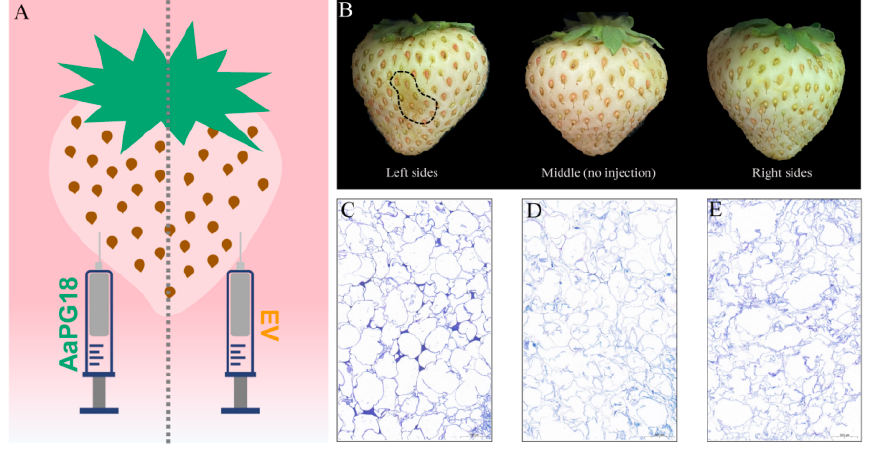
Figure 5. Transient overexpression in fruits of strawberry “snow”. ( A ) Diagrammatic sketch of the transient injection on the left and right sides of the same fruit of strawberry. ( B ) Phenotype observation of strawberry three days after injection. ( C ) Morphological observation of the cell section of strawberry fruit infiltrated with pBI121–AaPG18. ( D ) Morphological observation of the cell section of strawberry fruit without any injection. ( E ) Morphological observation of the cell section of strawberry fruit infiltrated with pBI121 (empty vector) as the control. The scale bar: 200 μ m.